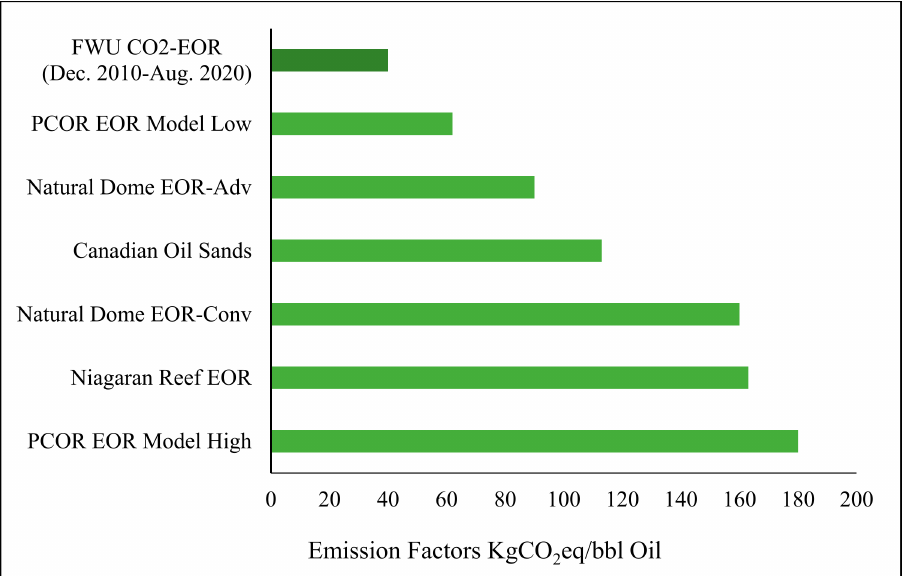
Figure 7. Reproduced gate-to-gate emission factors of other CO 2 -EOR fields [9], in comparison to FWU CO 2